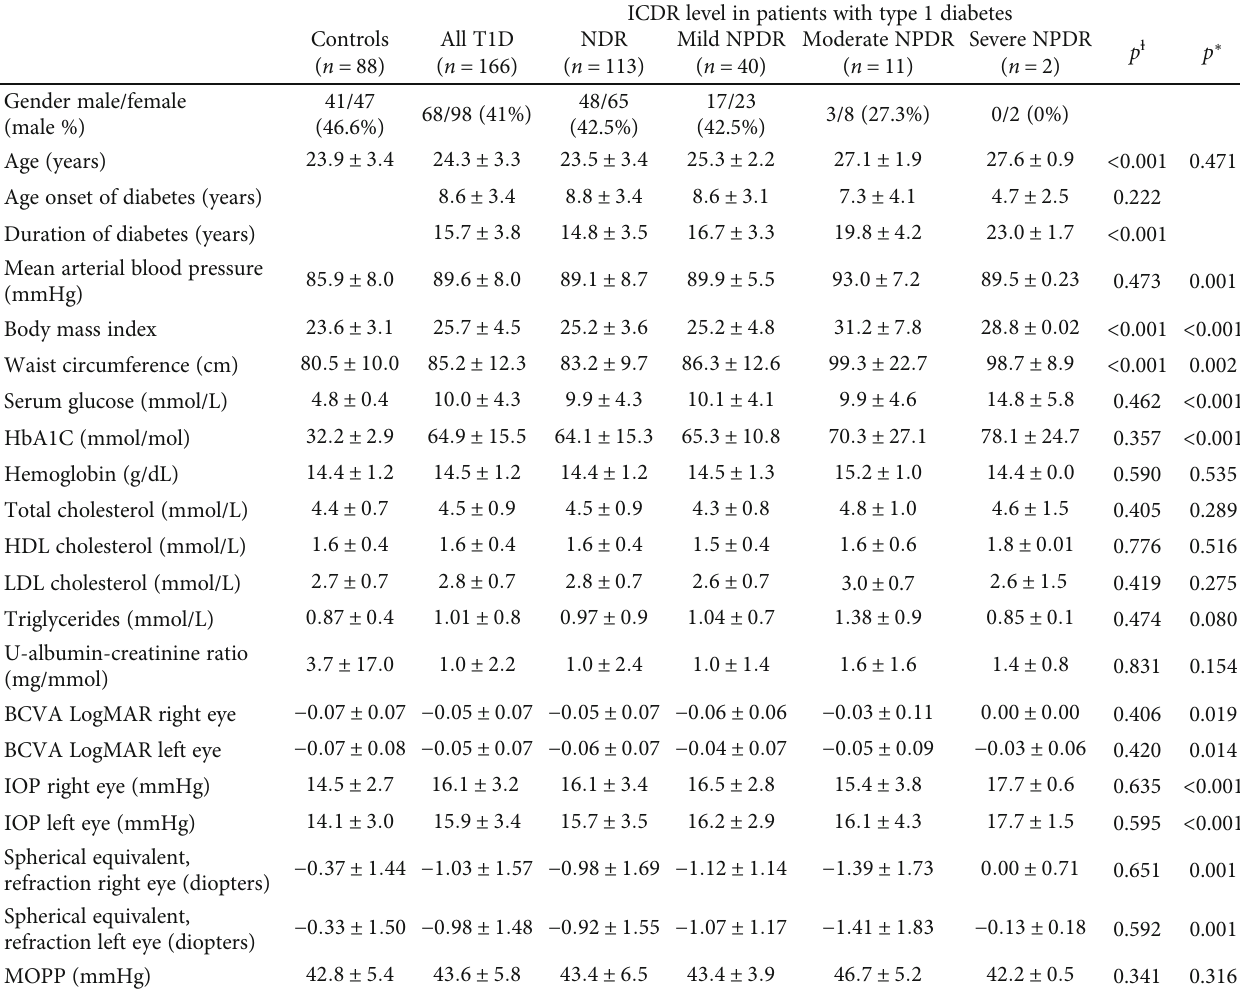
Table 1: Demographic and clinical characteristics of study patients ( n = 254 individuals). ICDR level in patients with type 1